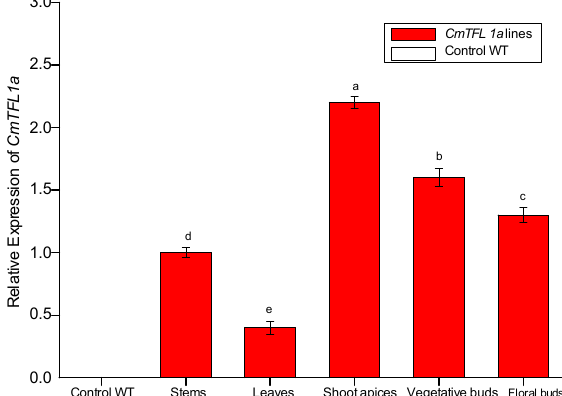
Figure 7. Relative expression of CmTFL1a in chrysanthemum cv. Jinba. Expression of CmTFL1a in various tissues of chrysanthemum by qPCR analysis. Actin was used as a reference gene. Three biological replicates were used for each sample. Error bars represent ± SD. a, b, c, d, and e are statistically significant at p ≤ 0.05 by ANOVA on ranks test.